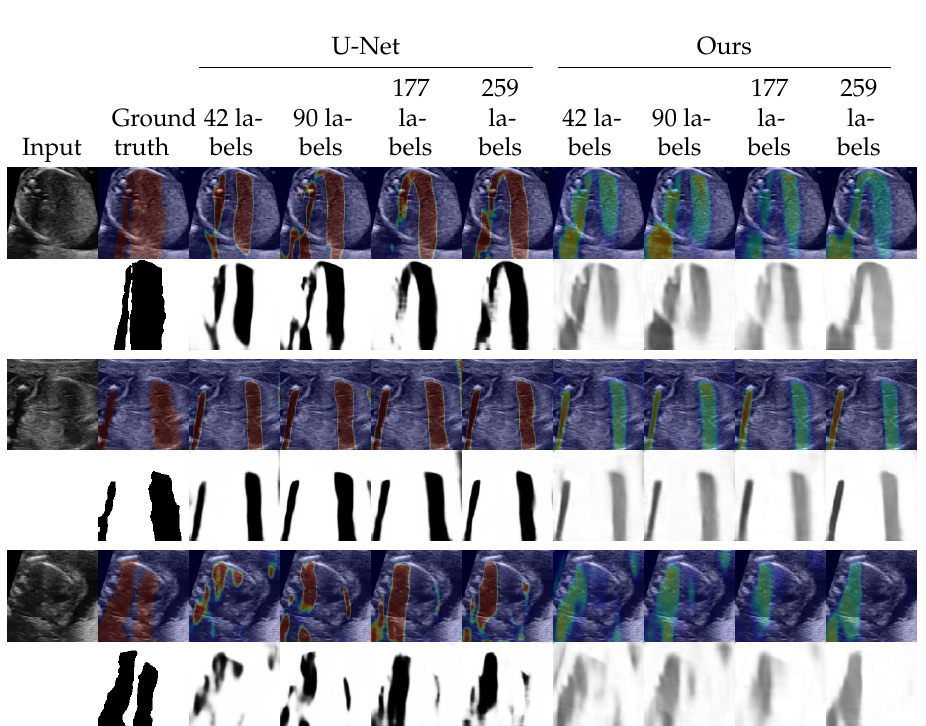
Figure A3. Additional examples of shadow detection results for the methods that use labels. The lower side of each example shows detection results, and the upper side shows them overlayed to the input image. For overlayed images, blue corresponds to low intensities and red corresponds to high